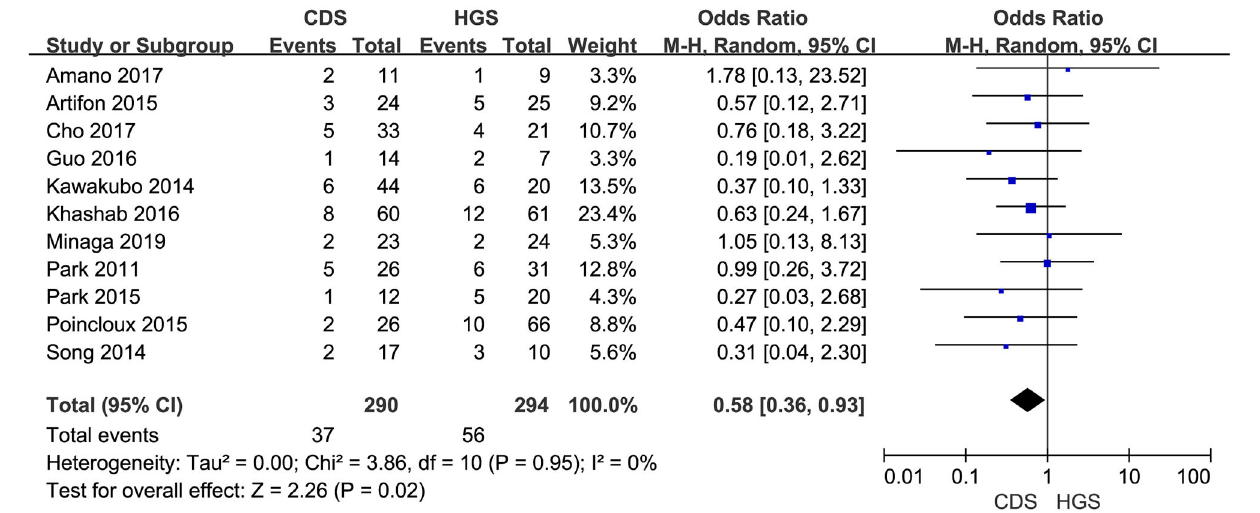
FIGURE 9 | Forest plot of early adverse events between EUS-CDS and EUS-HGS.